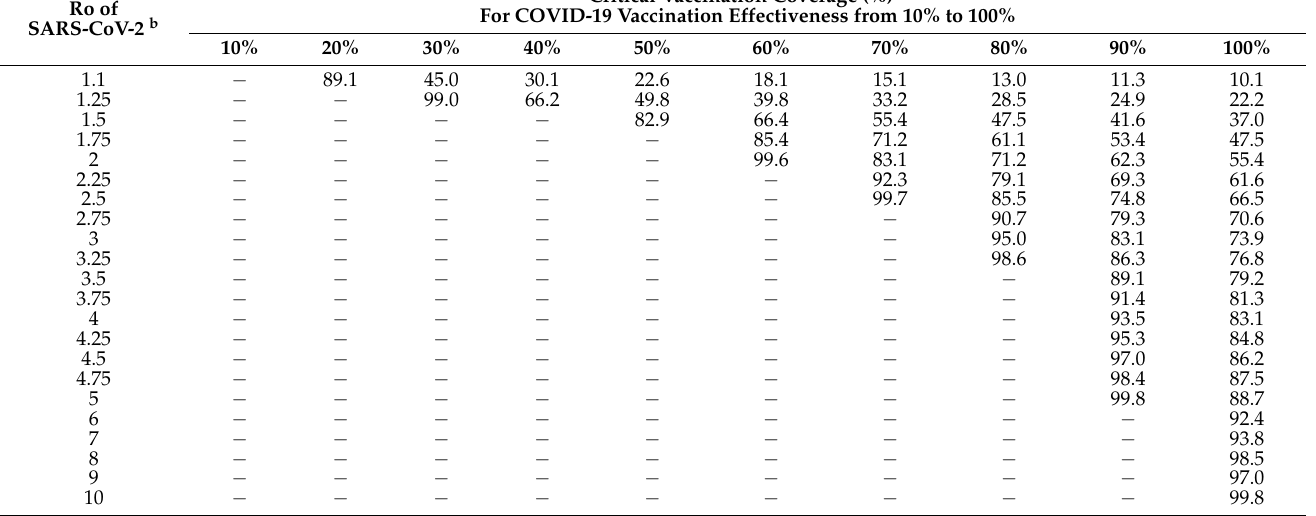
Figure 2. Vaccination coverage (%) required to establish herd immunity against SARS-CoV-2 with different reproductive numbers (R o ) by vaccination effectiveness (%) in a population with 9.8% of infections among vaccinated individuals. Objectives of vaccination coverage of 70%, 80%, and 90% are indicated with dashed red, blue, and green lines, respectively. Table 2. Critical vaccination coverage (V c ) required to establish herd immunity against SARS-CoV-2 with reproductive numbers (R o ) from 1.1 to 10 by vaccination effectiveness (%), with 9.8% of infections among vaccinated